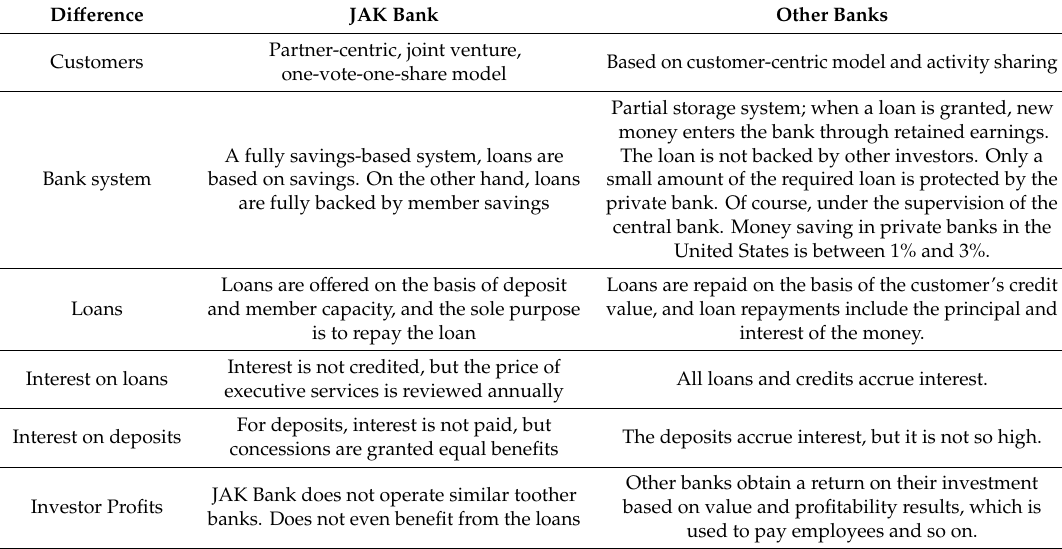
Table 1. JAK Bank di ff